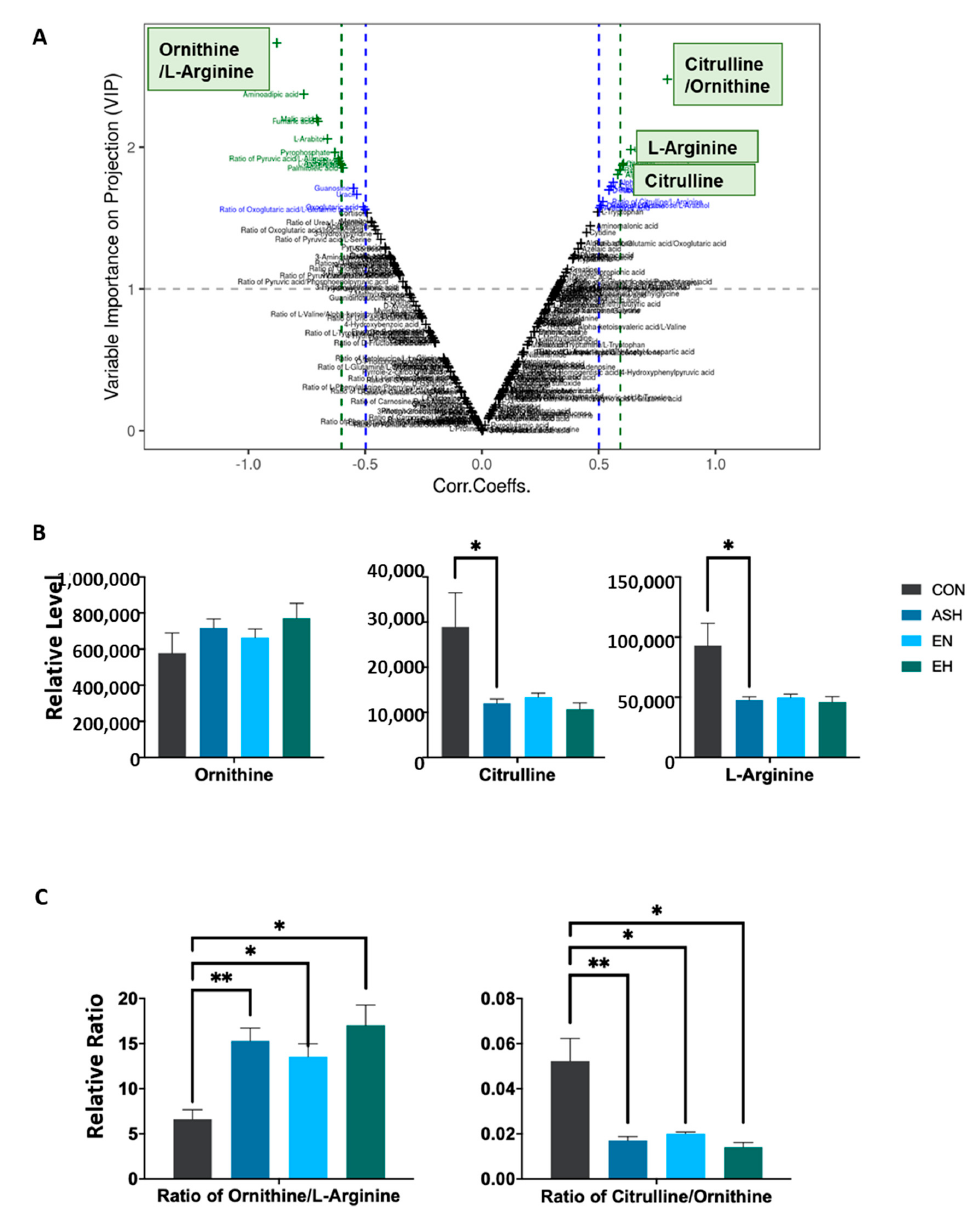
Figure 4. Significantly dysregulated amino acids and their ratios in asthma and control cohorts. ( A ) The volcano-plot combining the strength of both contribution (variable importance in projection) and variable reliability (correlation coeffi- cients). The value of VIP score which is greater than 1 is the typical rule for selecting relevant variables. With a significance level of 0.05, a corresponding Corr. value is used as a cutoff value to select the variables that are most correlated with the very first predictive component. The green metabolites were reliable metabolite markers based on VIP and Corr. Of interest, the metabolites L-arginine and citrulline and the metabolites ratio of ornithine/L-arginine and citrulline/ornithine exhibited VIP score greater than 1 with significance corresponding Corr. ( B ) Relative serum levels of L-arginine, citrulline and ornithine and the ratio of ornithine/L-arginine and citrulline/ornithine ( C ) among asthma, asthma with normal eosinophilia, asthma with high eosinophilia and control participants. Data were analyzed using the one-way ANOVA. Mean s.e.m. * p < 0.05. ** p < ±